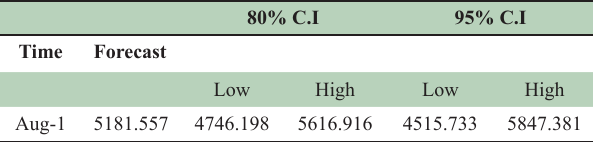
Table-II: Detail of estimated parameters along with S.E, ARIMA (0, 2, 1).